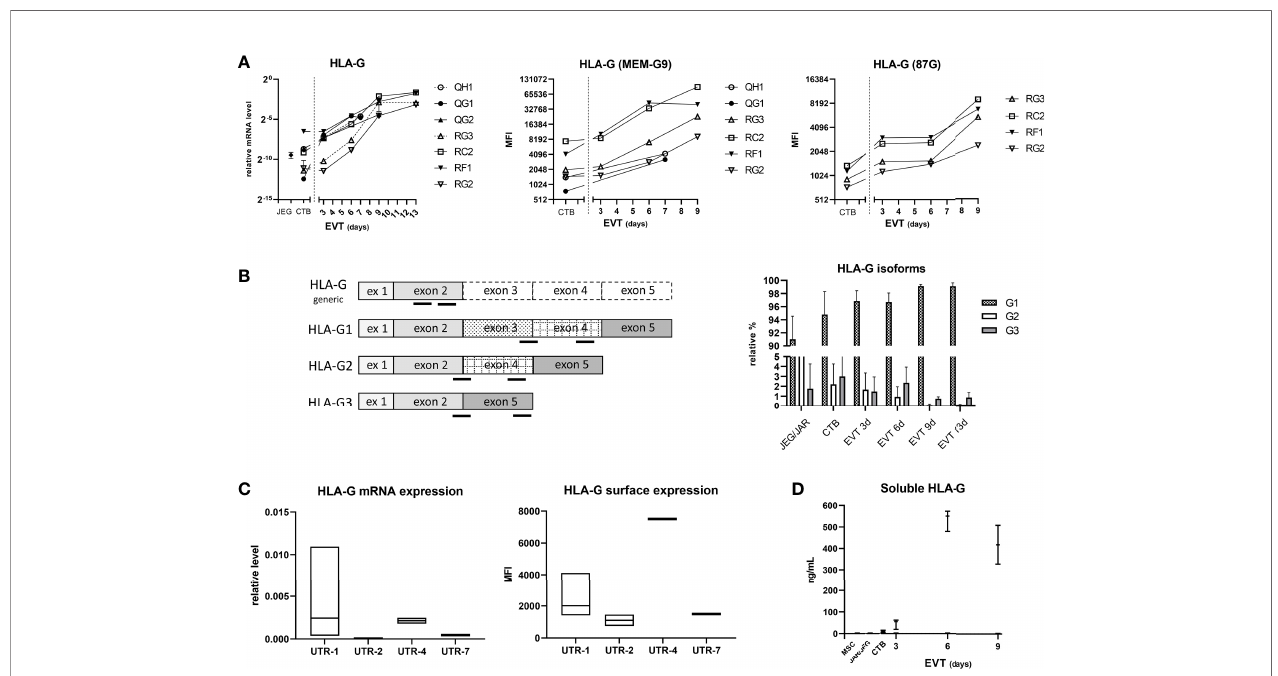
FIGURE 6 | Expression of HLA-G in trophoblasts. (A) HLA-G mRNA expression was determined by quantitative PCR using generic primers that targeted all alleles (left panel). HLA-G was also studied by fl ow cytometry using antibodies against HLA class I and two epitopes on HLA-G1 and -G5 isoforms (MEM-G9 and 87G), respectively (middle and right panel). (B) HLA-G1 , G2 , and G3 isoforms were separately studied by using isoform-speci fi c primer sets (annealing locations indicated by black bars in the left panel). The results in the right panel are displayed as means with SD of n = 4 primary cultures. (C) HLA-G expression according to HLA-G 3 ’ -UTR haplotype. Messenger RNA expression of HLA-G from seven CTB cultures was analyzed by quantitative PCR (corrected for the average signal of reference genes GAPDH and ACTB ; left panel), whereas information of HLA-G surface expression by fl ow cytometry against MEMG9 was available for six CTB cultures (right panel). Expression data were grouped according to haplotype: UTR-1 (n = 4), UTR-2 (n = 2), UTR-4 (n = 2) or UTR-7 (n = 1). The graphs show fl oating bars (min to max with line at median). (D) Soluble HLA-G levels were determined by ELISA in supernatant of CTB (n = 3), EVT (n = 3), JEG-3 and JAR cell lines, and MSC (n = 2). The graph shows medians with the whiskers representing minimum and maximum